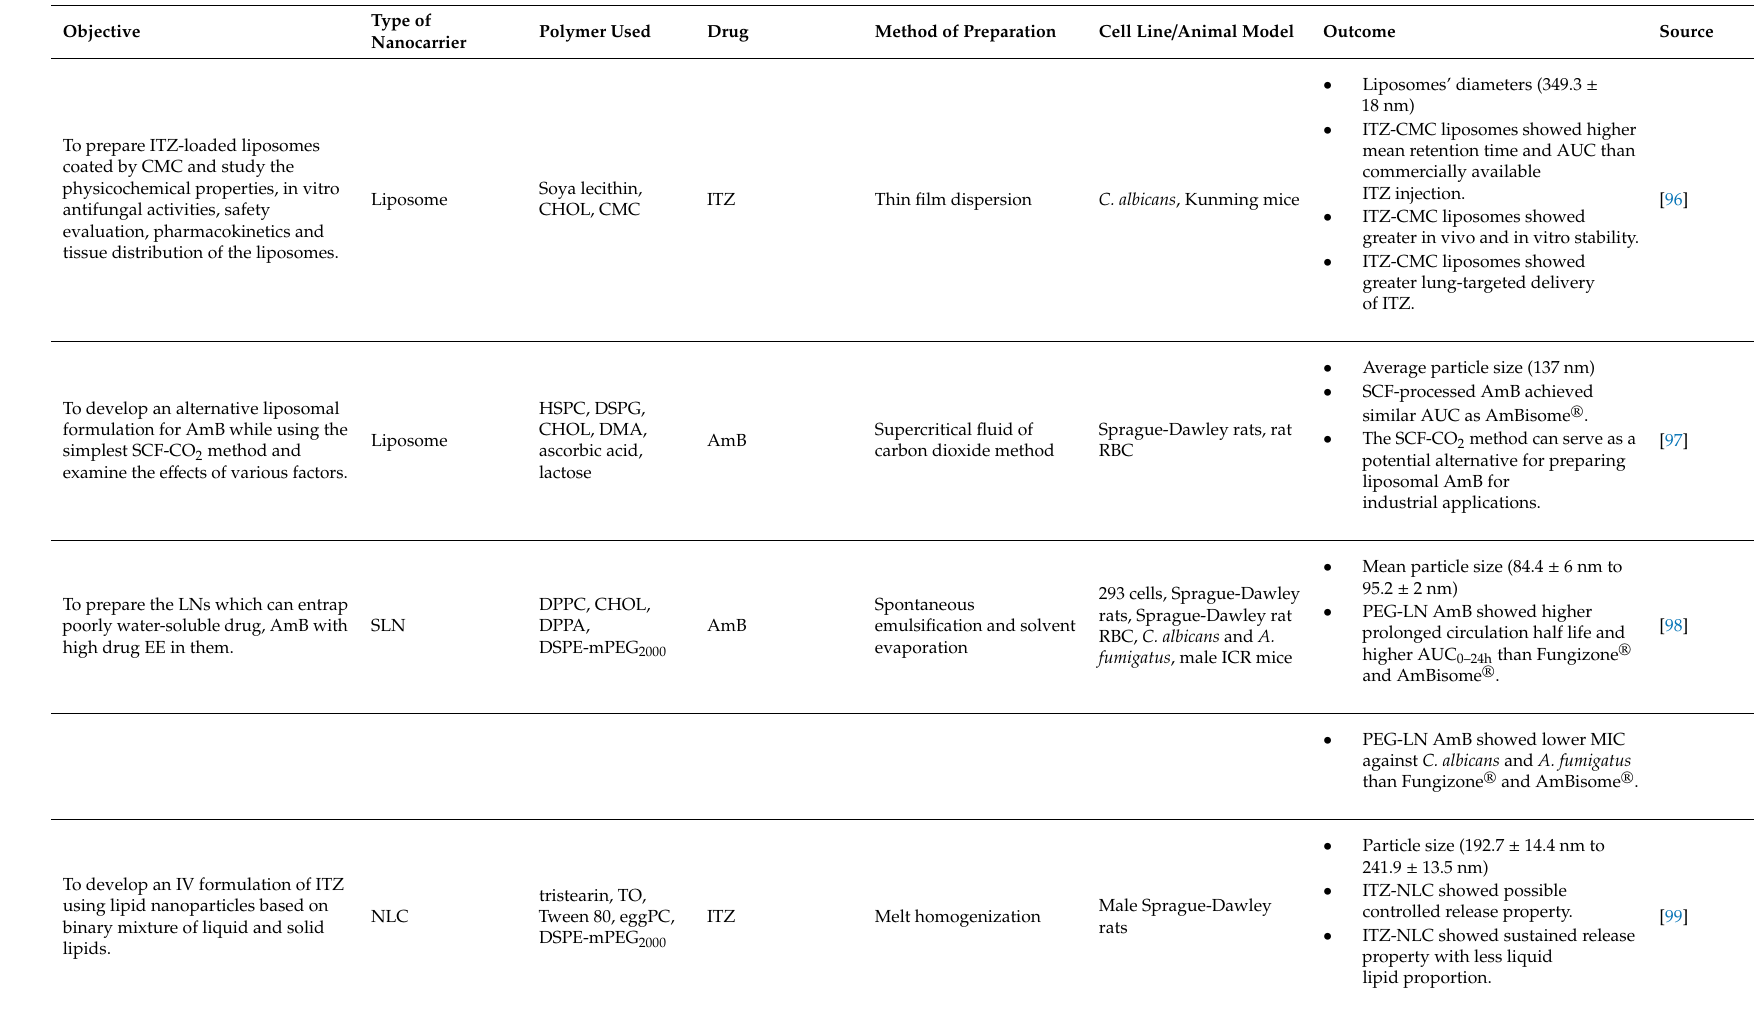
Table 5. Nanocarriers for intravenous formulation against pulmonary